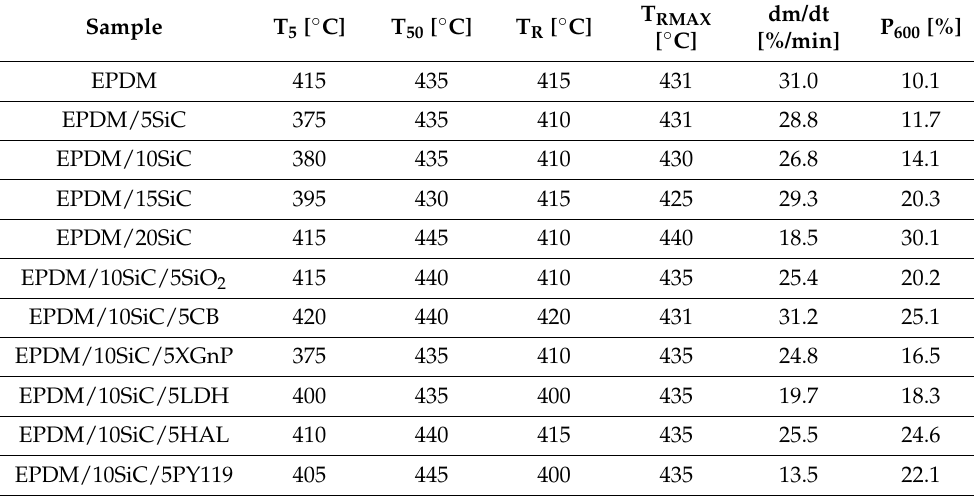
Table 6. Thermal stability of EPDM-filled